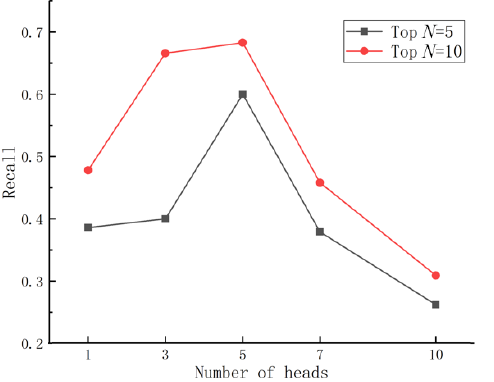
Fig. 4 Recall with different numbers of heads on the Huajiao dataset.